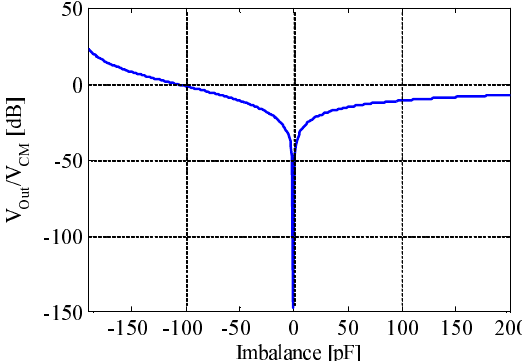
Figure 5. Simulated result of output voltage normalized to CM noise input for capacitance imbalance − 200 pF to 200 pF (Table 1’s